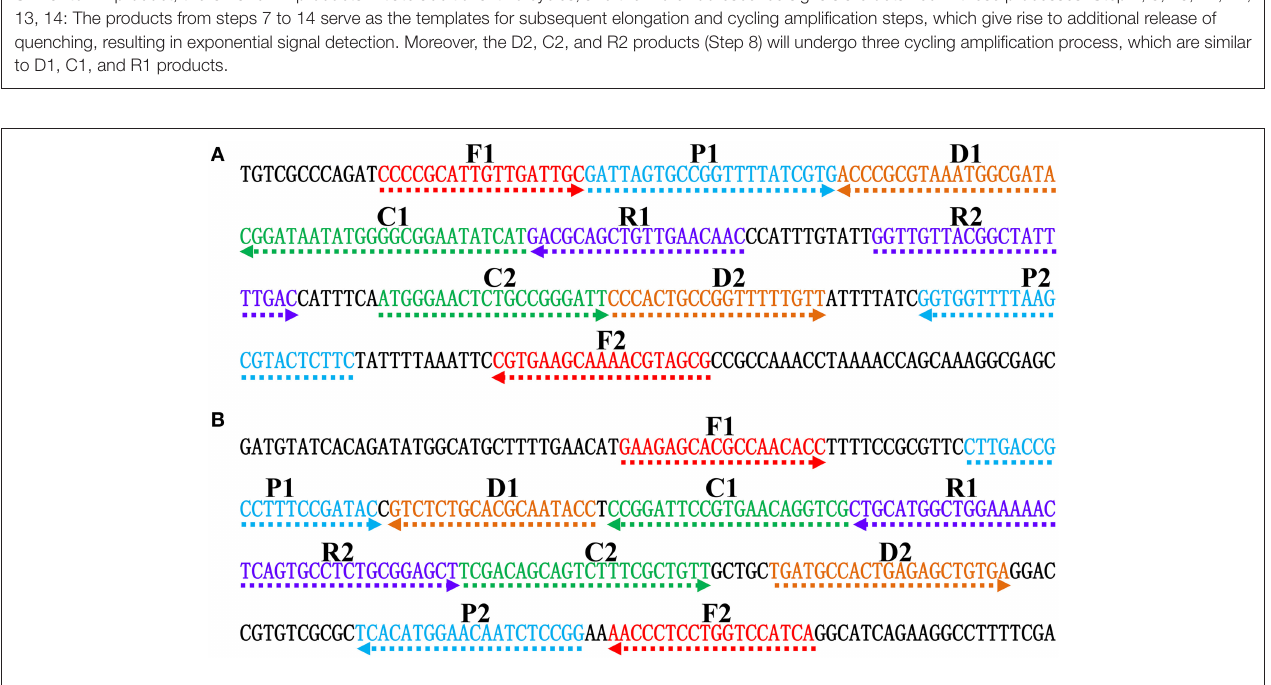
FIGURE 2 | Nucleotide sequence and location of Salmonella ( invA ) and Shigella ( ipaH ) genes used to design ET-MCDA primers. The nucleotide sequences of the sense strands of invA (A) and ipaH (B) are listed. The sites of primer sequences were underlined. Left arrows and right arrows showed complementary and sense sequences that are